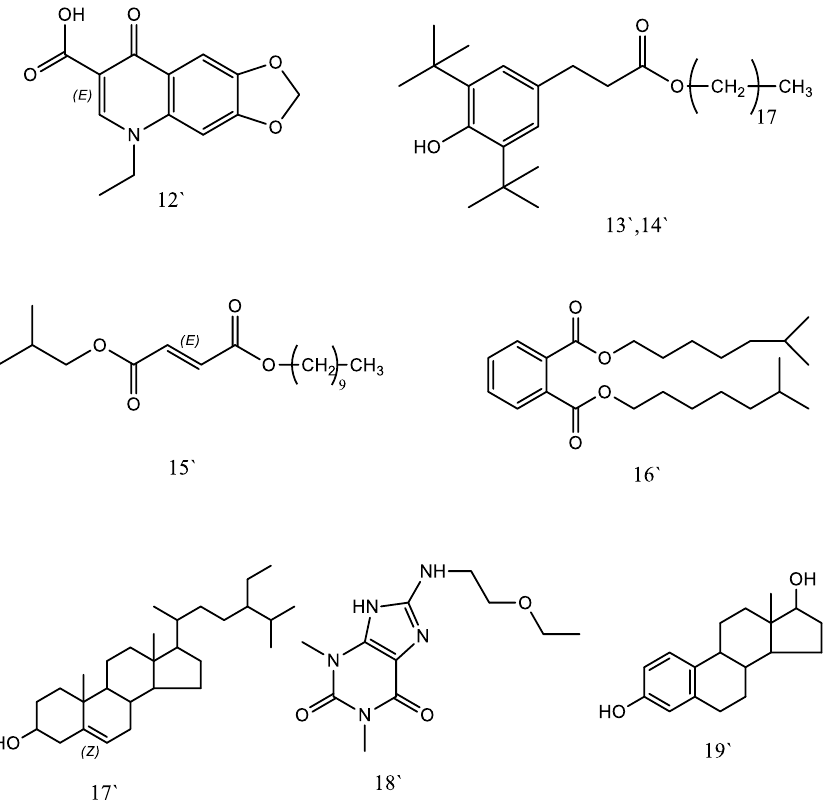
Figure 7. Structure of phytochemicals identified in methanol extracts of immature (K I ) fruits of K. pinnata . Table 8. Phytochemical compounds identified by LC-MS/MS in crude methanolic extracts of mature (K m ) fruits of K. pinnata in positive (TIC 1) and negative (TIC2) ion modes. Peak No.